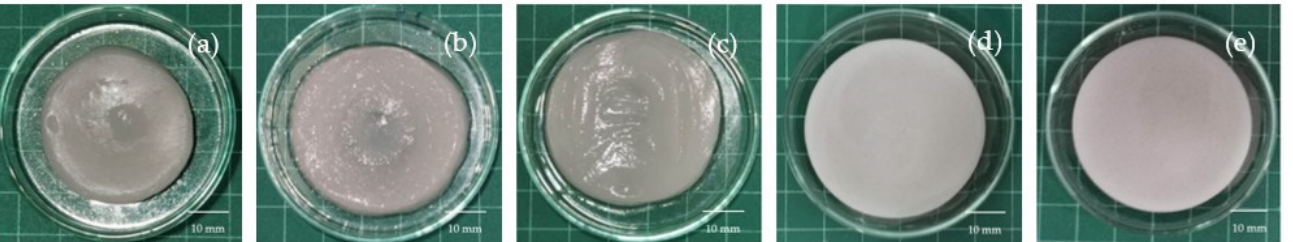
Figure 4. The appearance of WHC-composited hydrogels: C 1 A 0.5 P 0.5 ( a ), C 1.5 A 0.5 P 0.5 ( b ), C 2 A 0.5 P 0.5 ( c ), C 2.5 A 0.5 P 0.5 ( d ), and C 3 A 0.5 P 0.5 ( e ). Table 1. The thickness and diameter of WHC-hydrogels.